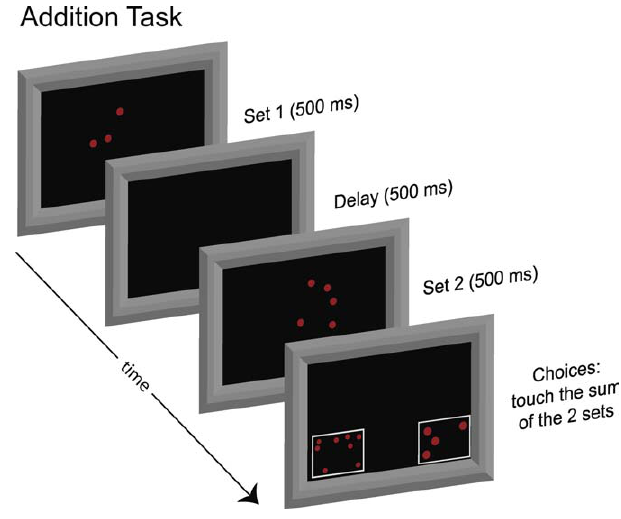
Figure 1. The Addition